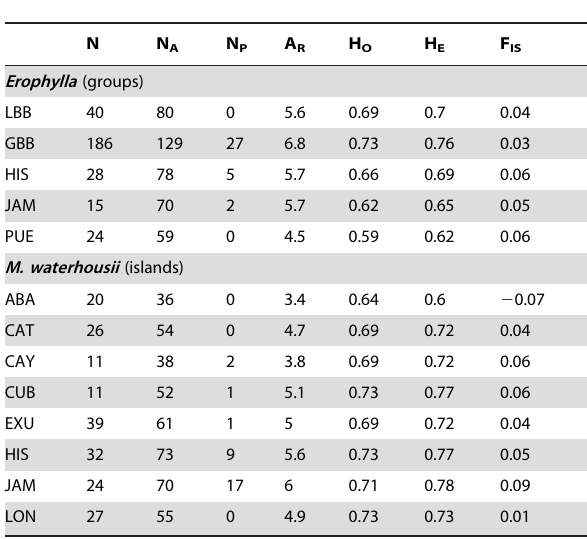
Table 1. Sample size (N), number of alleles (N A ), number of private alleles (N P ), mean allelic richness (A R ), observed (H o ) and expected (H E ) heterozygosity and estimates of inbreeding coefficient (F IS ) over all loci for Erophylla among groups and M. waterhousii among